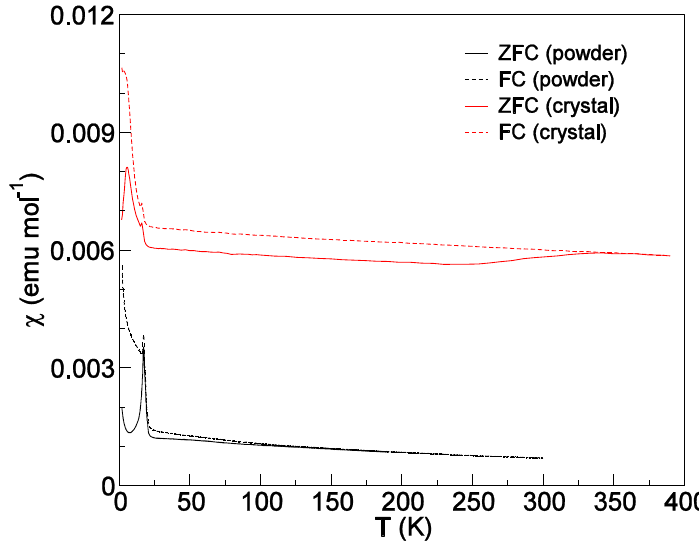
Figure 10. The zero-field cooled (ZFC) and field-cooled (FC) magnetic susceptibility data for a single crystal sample of Cs 2 TiCu 3 F 12 (red) compared to the powder-sample susceptibility (black), both measured in an applied magnetic field of 2